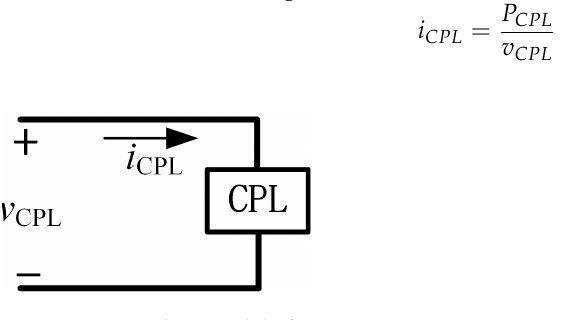
Figure 7. Equivalent model of CPLs.